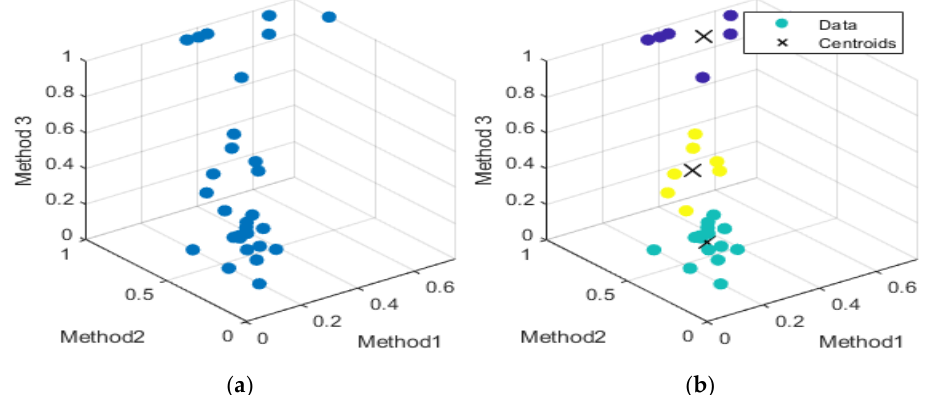
Figure 11. ( a ) Data set example without clustering technique applied.; ( b ) Data set example organized employing k-means clustering technique.